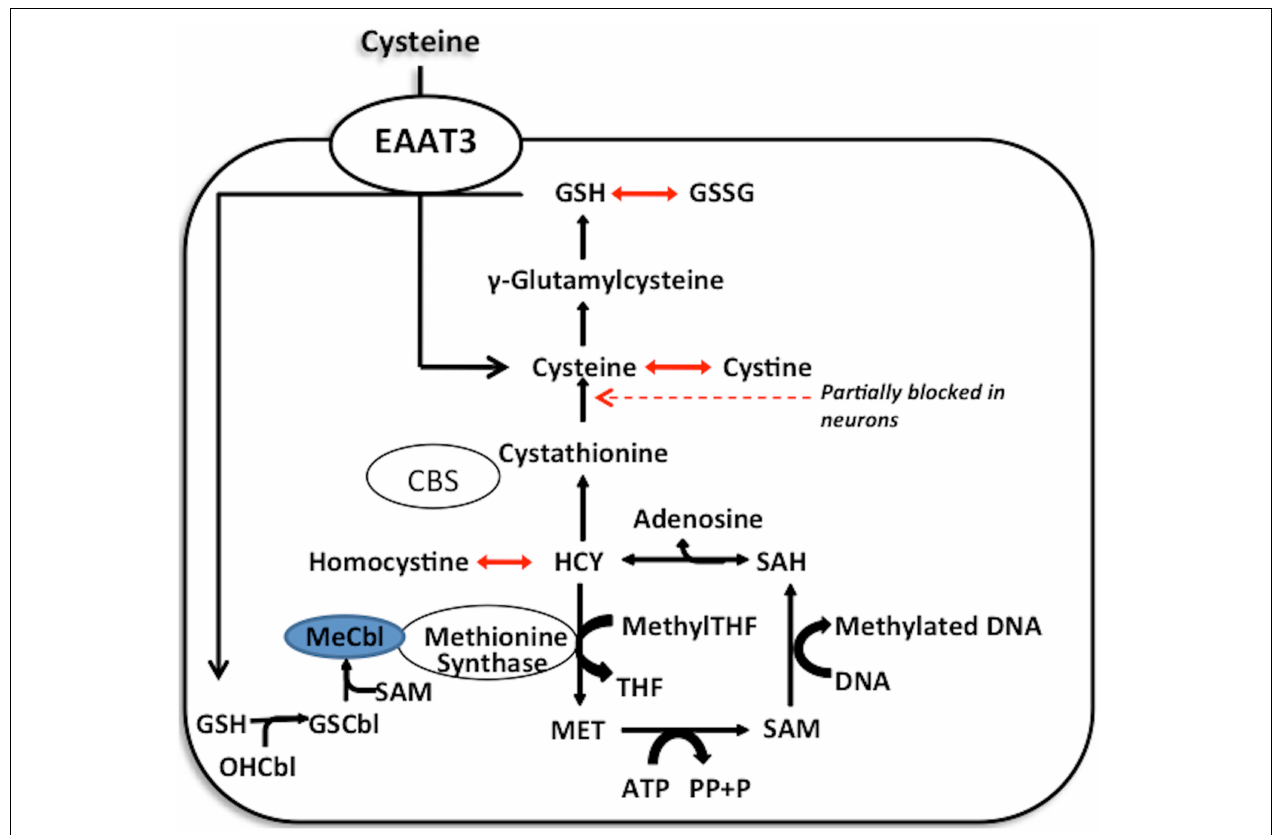
FIGURE 2 | Methionine synthase acts as a redox switch. Methionine synthase contains a redox-active methylcobalamin cofactor. Under oxidative stress, this cofactor becomes oxidized, limiting methionine synthase activity. Under these conditions, homocysteine can be condensed with serine to form